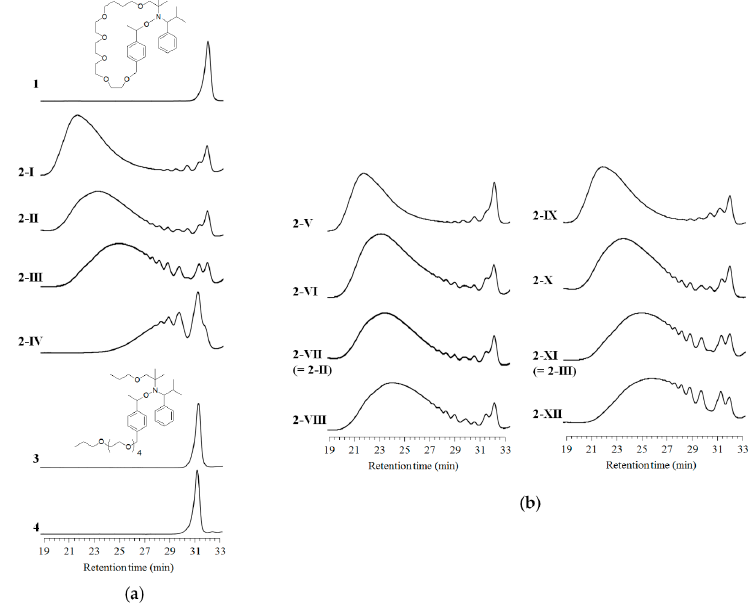
Figure 1. SEC traces of ( a ) 1 , 2-I~IV , 3 , and 4 and ( b ) 2-V ~ VIII and 2-IX ~ XII .